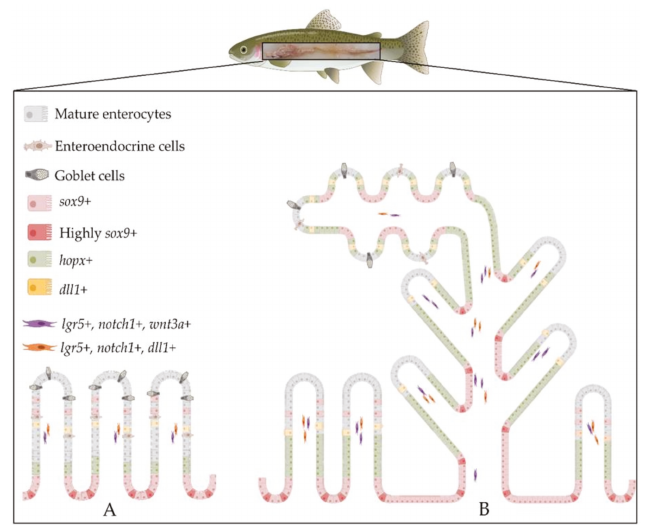
Figure 19. Schematic illustration of the architecture and the organization of the intestinal stem-cell niche in rainbow trout in the first ( A ) and second ( B ) segment of the mid-intestine. Sox9 was expressed at the base of the fold and the signal was downregulated along the fold length, where hopx expression increased and then faded in the upper portion of the folds. Lgr5 was exclusively expressed in scattered cells located in the lamina propria, where it colocalized with notch1 and wnt3a . Dll1 also colocalized with lgr5 in the lamina propria and it was expressed in the epithelium near lgr5 + stromal cells. The distribution of these markers along the rainbow trout intestine was not homogeneous; rather, we observed the highest expression in the basal part of the complex folds of the second segment of the mid-intestine compared to other districts. Illustrations created with BioRender.com.